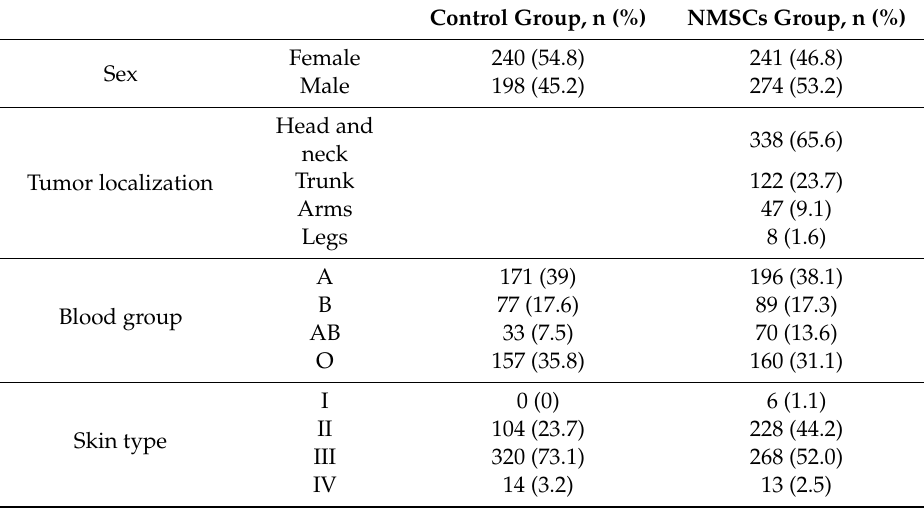
Table 1. Distribution of nonmelanoma skin cancers (NMSCs).